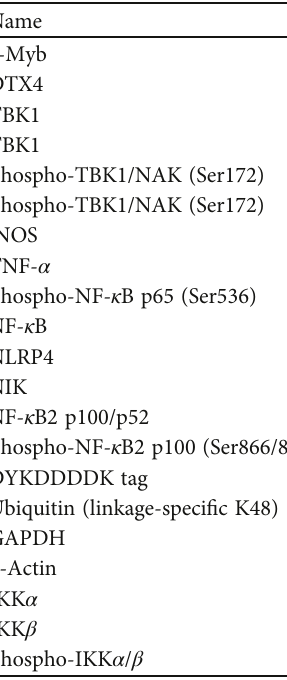
T ABLE 1: Information of relevant